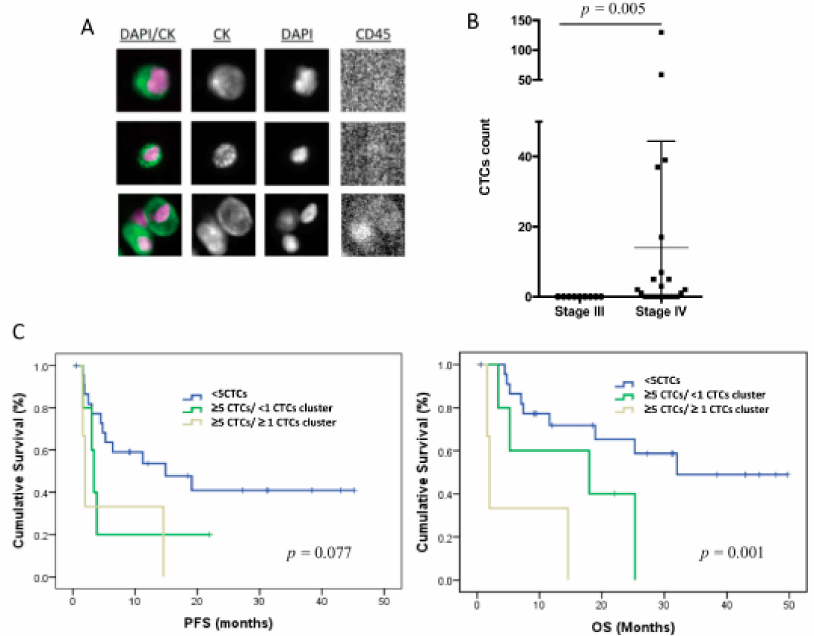
Figure 1. CTC enumeration by CellSearch system in TNBC patients ( n = 31). ( A ) CTC images obtained using CellSearch system (round-oval, DAPI + , CD45 − and CK + cells were considered as CTCs). ( B ) CTC count in stages III and IV TNBC patients using CellSearch system; p -value was calculated according to two-sided Mann–Whitney test. ( C ) Kaplan–Meier analysis for PFS and OS grouping patients